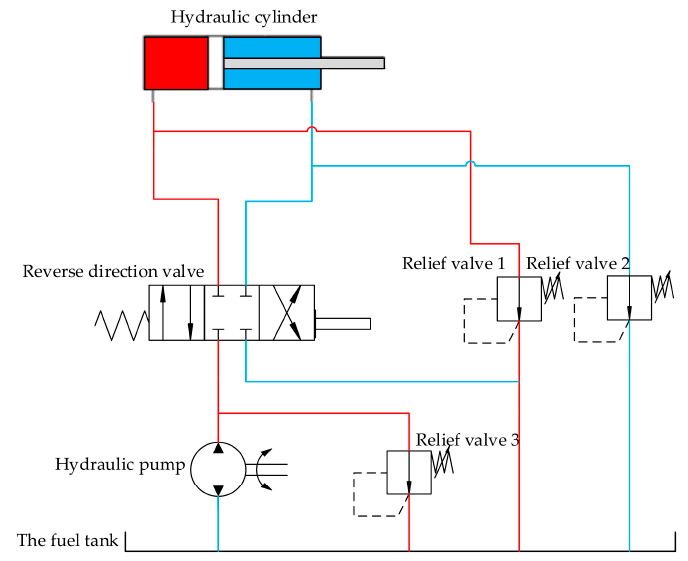
Figure 4. The schematic diagram of the hydraulic heightening system.